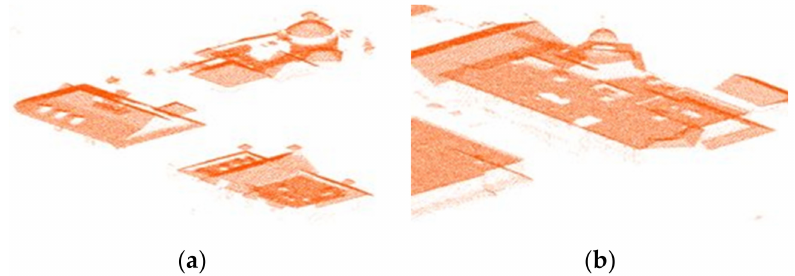
Figure 28. Examples of 3D perspective view of DALES data building point clouds: ( a ) test 1; ( b ) test 2.